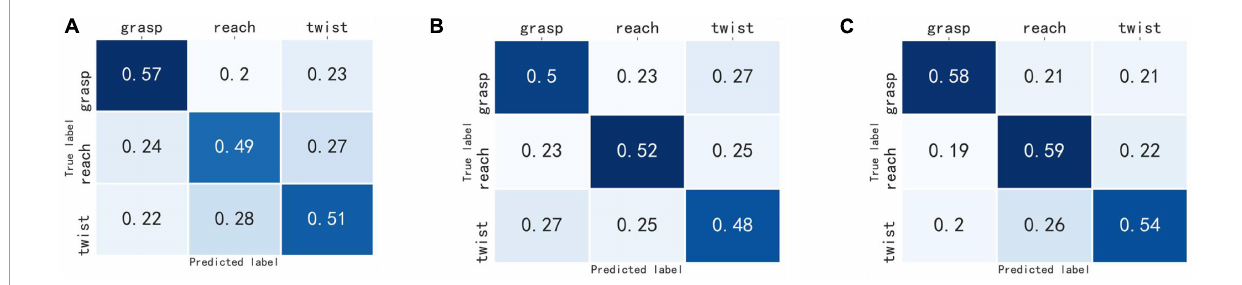
FIGURE6 Confusion matrix of the three-class classification experiment. (A) EEG-CNN, (B) TF-CNN, (C) MF-CNN.